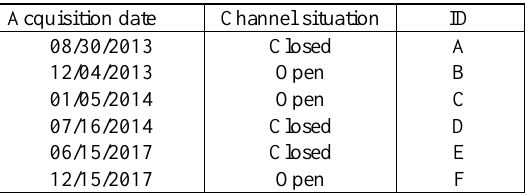
Table 1. Acquisition dates, channel situations and